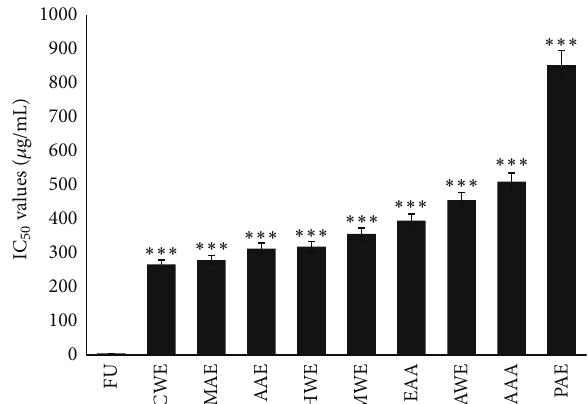
Figure 1: IC 50 value of HWE, CWE, MWE, AWE, EAA, AAA, PAE, AAE, MAE, and 5-FU on NRK-52E cells measured by MTT assay after 48 hours of treatment. Data presented as mean ± S.D ( 𝑛 = 3 ) and compared to IC 50 value of 5-FU. ∗∗∗ 𝑃 < 0.001